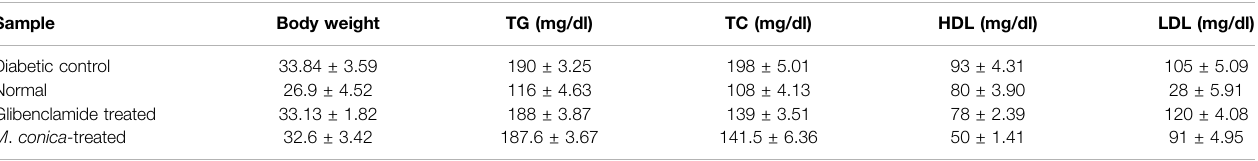
TABLE 1| Levels ofTG,TC,HDL and LDLinthenormal, diabetic control,and glibenclamide and M . conica -treated micegroup. Valuesaremeansoftriplicatedetermination ( n (cid:2) 3) ± standard deviation. Sample Body